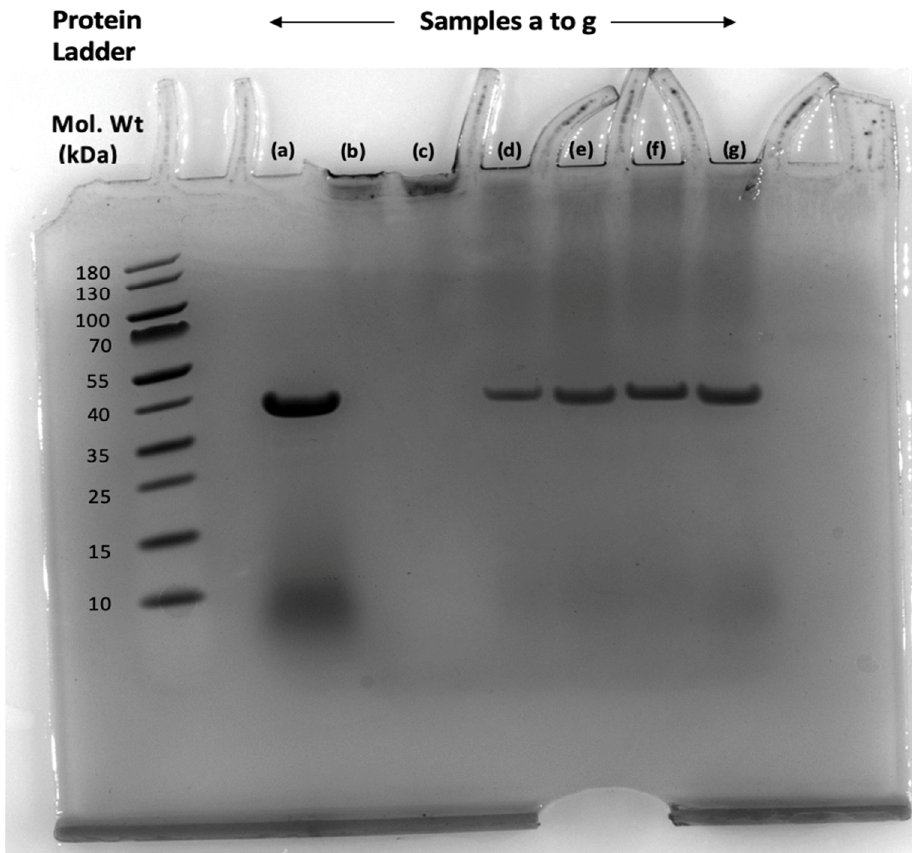
Figure 3. Gel electrophoresis of pepsin with and without binding to the tannins and PEG. From left to right after protein ladder: ( a ) pure pepsin, ( b ) pepsin + Asco phlorotannin, ( c ) pepsin + Fucus phlorotannin, ( d ) pepsin + Asco phlorotannin + PEG 2000MW, ( e ) pepsin + Asco phlorotannin + 4000MW, ( f ) pepsin + Fucus phlorotannin + PEG 2000MW and ( g ) pepsin + Fucus phlorotannin + PEG 4000MW .